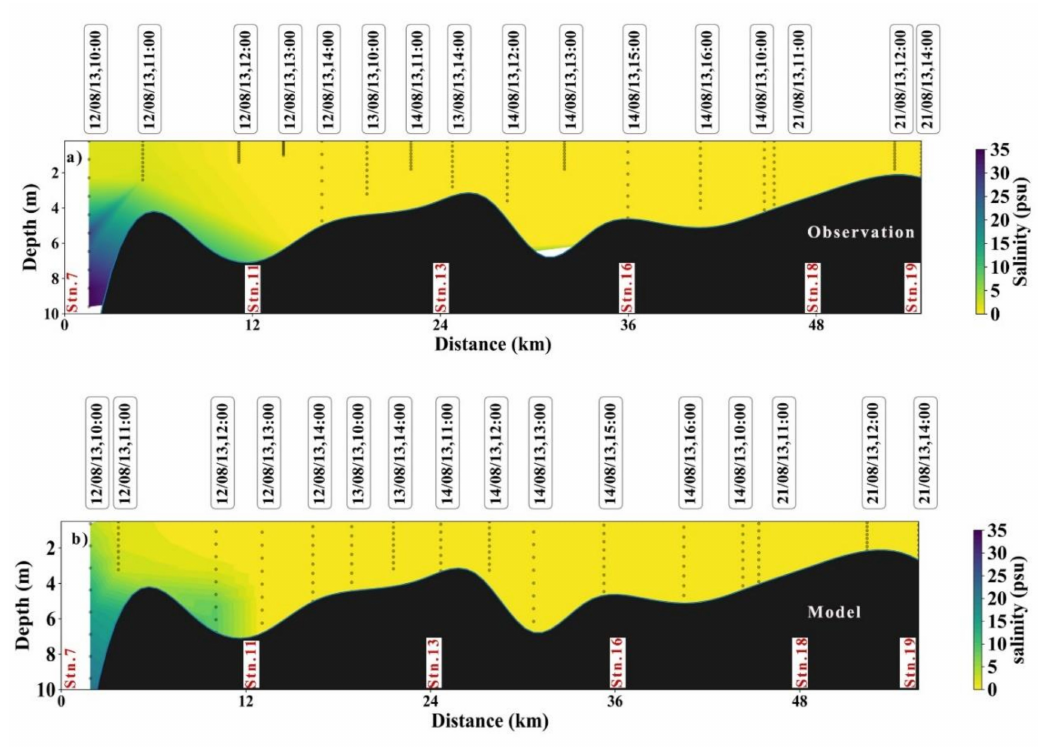
Figure 9. Validation of vertical salinity at CE during the period of 12–21 August 2013 ( a ) observation and ( b ) model.